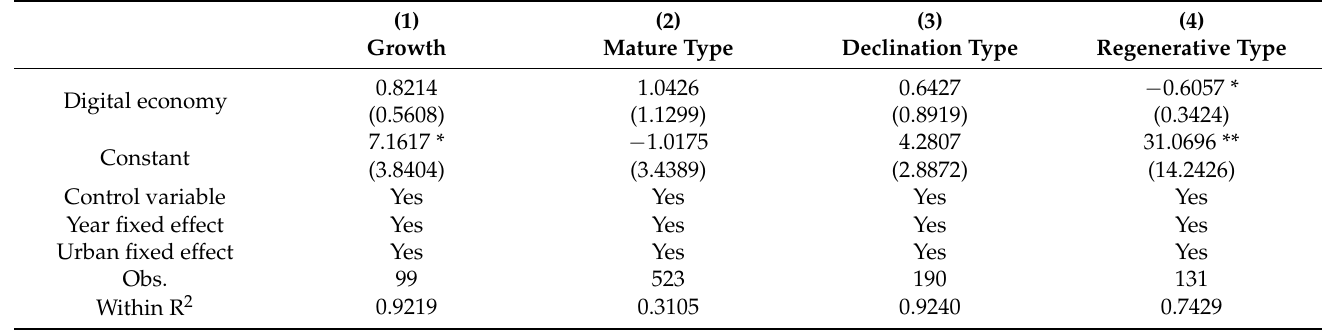
Table 11. Regression results of samples of resource-based cities and non-resource-based cities.